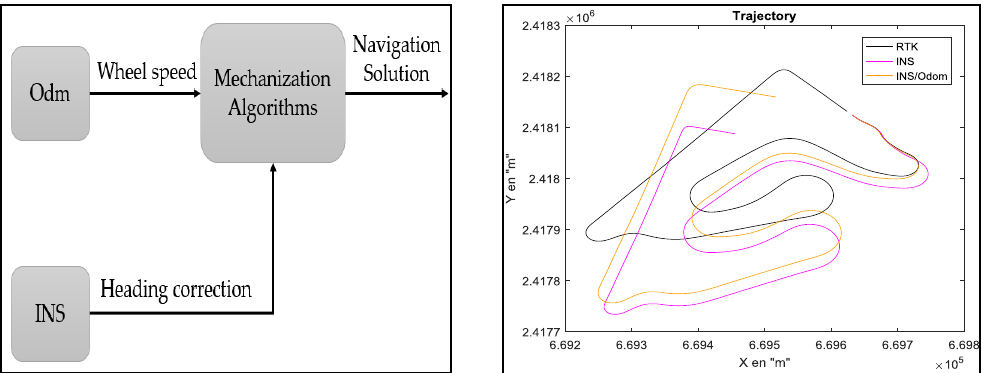
Figure 12. Schematic diagram of the INS/Odo integration.